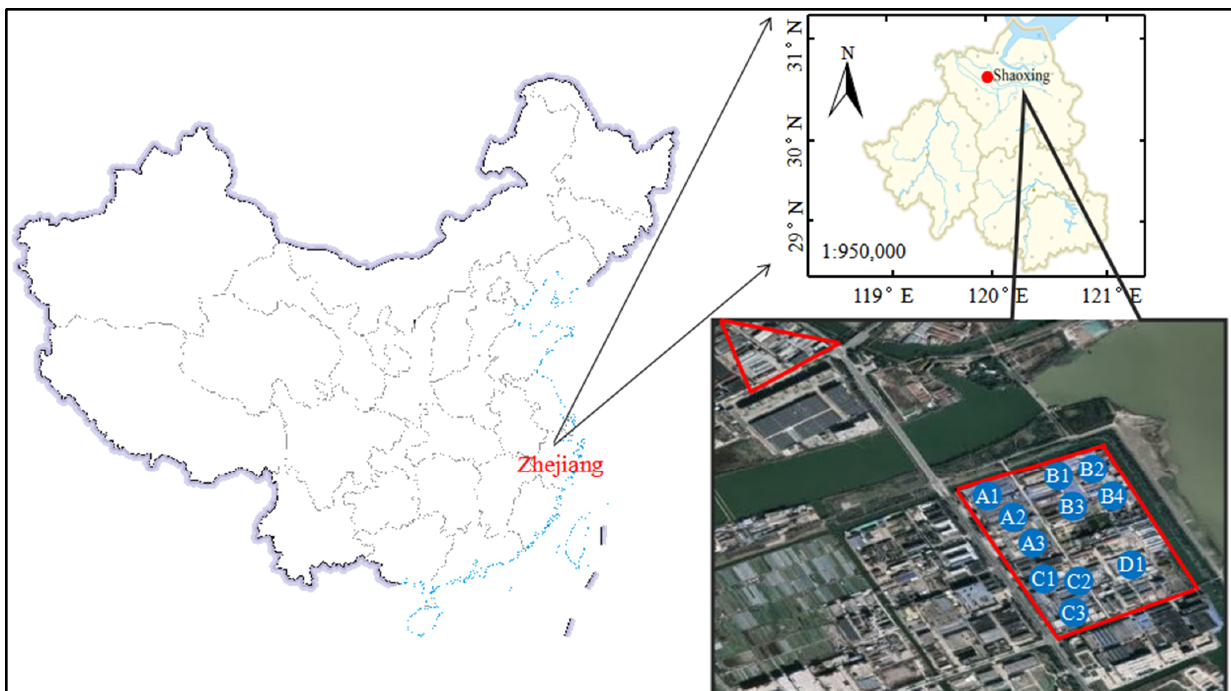
Figure 1. Experimental site: textile dyeing industrial park, Shaoxing, China. The red rectangle square represented the textile dyeing industrial park, and the red triangle represented the resident area. The chimney numbers were pointed in the red rectangle square with blue circles. Table 1. The detailed process of exhaust from the eleven chimneys in four textile dyeing enterprises. Chimney